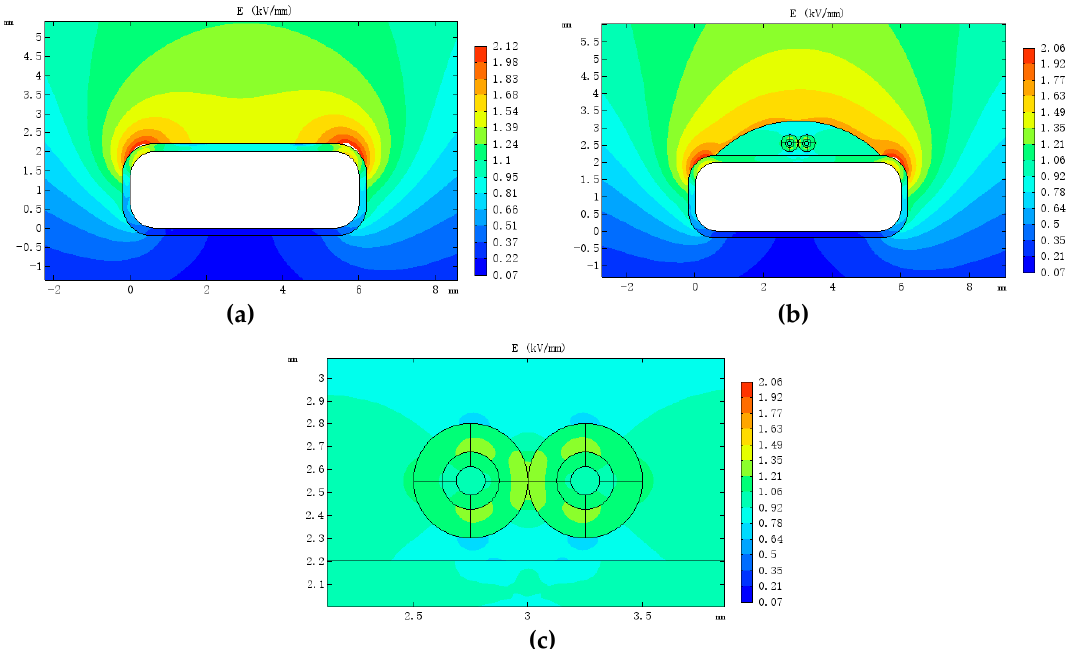
Figure 4. ( a ) Electrical field distribution of original conductor; ( b ) electrical field distribution of optical fibre composite conductor and ( c ) electrical field distribution in the optical fibre.